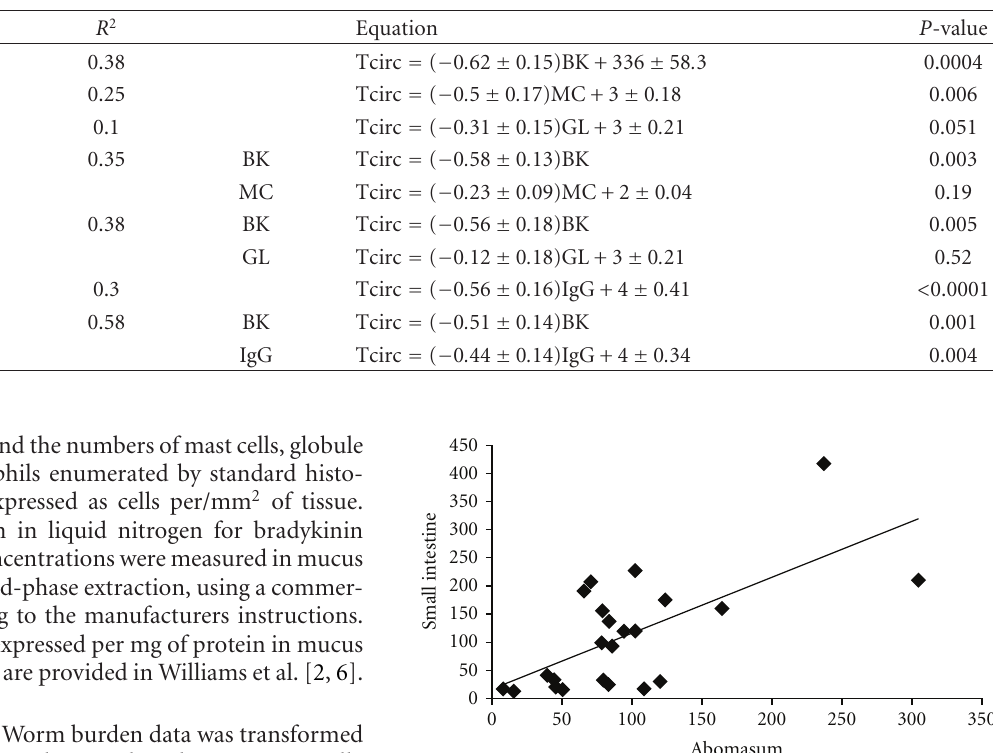
adult T. circumcincta burden (Tcirc) and the concentrations of bradykinin 10